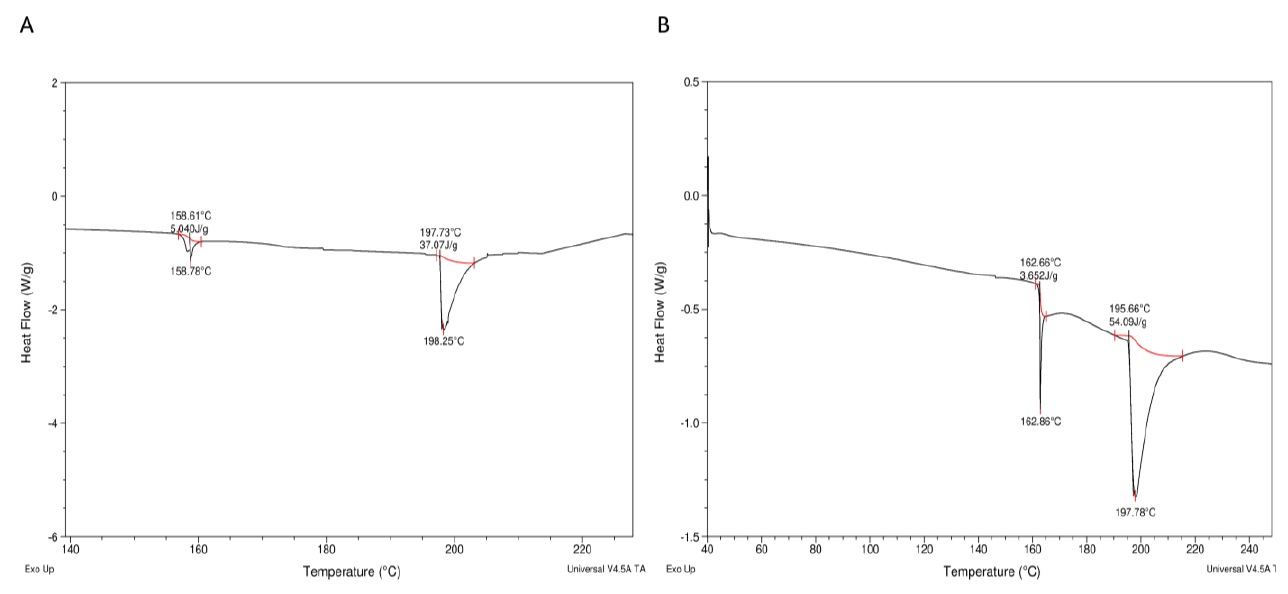
Figure 4. Differential scanning calorimetry (DSC) thermograms for the protein extracts from HLPE ( A ) and HPPE ( B ).